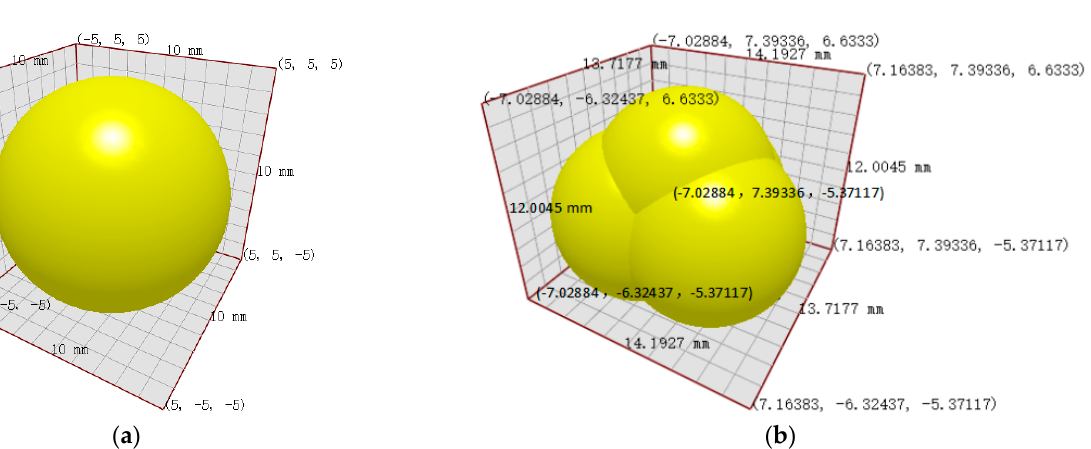
A 3200 mm (Length), 1600 mm (Width) and 300 mm (Height) soil tank model was plotted by Solidworks. The model was assembled with the simplified key components and stored in the format of *.igs. The corresponding data were input into EDEM. Mean- while, two-particle factories were set to produce the soil model and green manure stalk model. The size of the particle factory which generates soil was consistent with the soil tank model. According to soil density and soil tank area, a total of 1200 kg of soil particles were generated within 0~2 s for the convenience of calculation. After 4s, the soil model and green manure stalk model were completed (Figure 6a). The rotary tillage depth of the whole model was 15 cm. The “stalk pressing plate” of the compacting machine entered into the soil completely. By calculating the transmission ratio, the general advancing speed was fixed at 1.2m/s, while the axial rotating speed of the rotary tillage cutters was fixed at 600r/min. Since the compacting machine cannot rotate automatically, its rotating speed was calculated to be 327.27r/min according to the advancing speed and perimeter of the compacting machine. The operation time of the machine was 4~7 s. For the conven- ience of calculation, the time step length was fixed at 20% of Rayleigh and the grid unit size was fixed at 5 times the minimum particle radius.